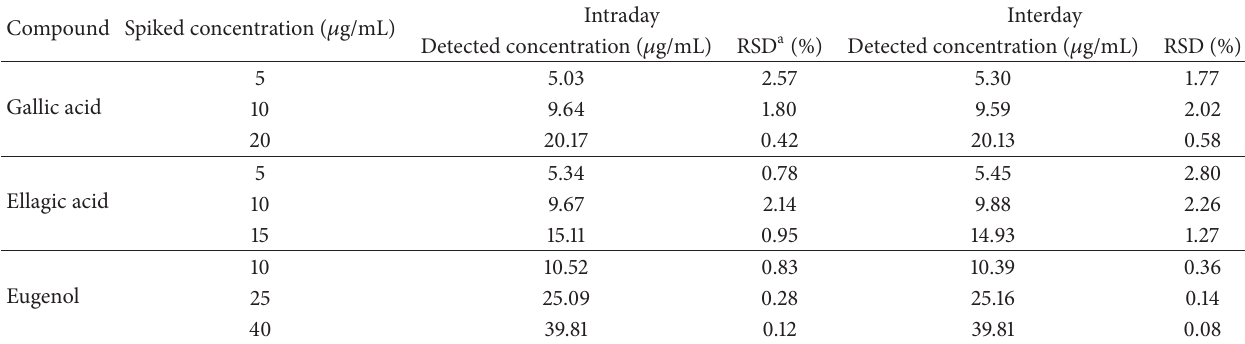
Table 2: Intraday and interday precision of three reference compounds in Syzygium aromaticum extract ( 𝑛 = 3 ). Compound Spiked concentration ( 𝜇 g/mL)